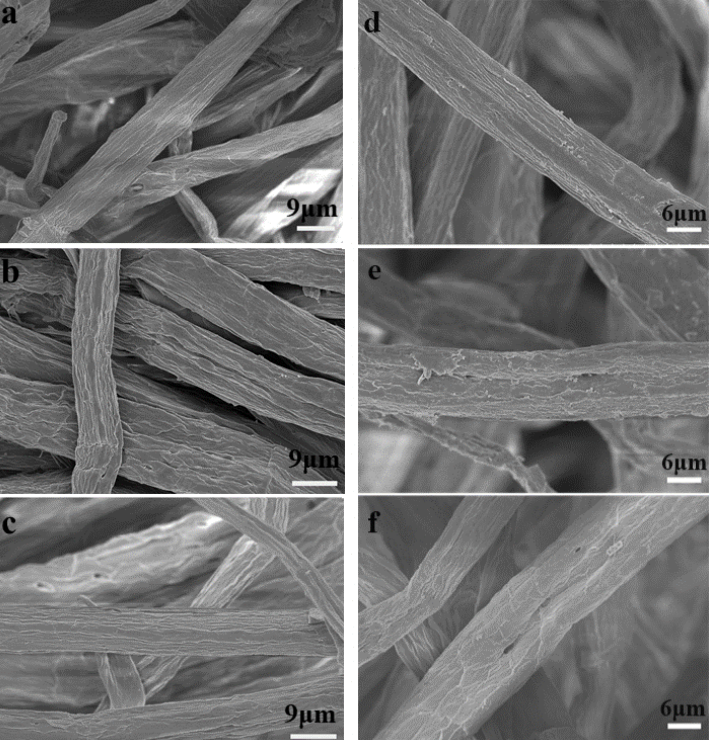
Figure 1. SEM images of oxygen-delignificated kraft pulps with or without IL pretreatments: ( a ) control pulp, ×1800; ( b ) [BMIM][HSO 4 ] pretreated pulp, ×1800; ( c ) [TEA][HSO 4 ] pretreated pulp,